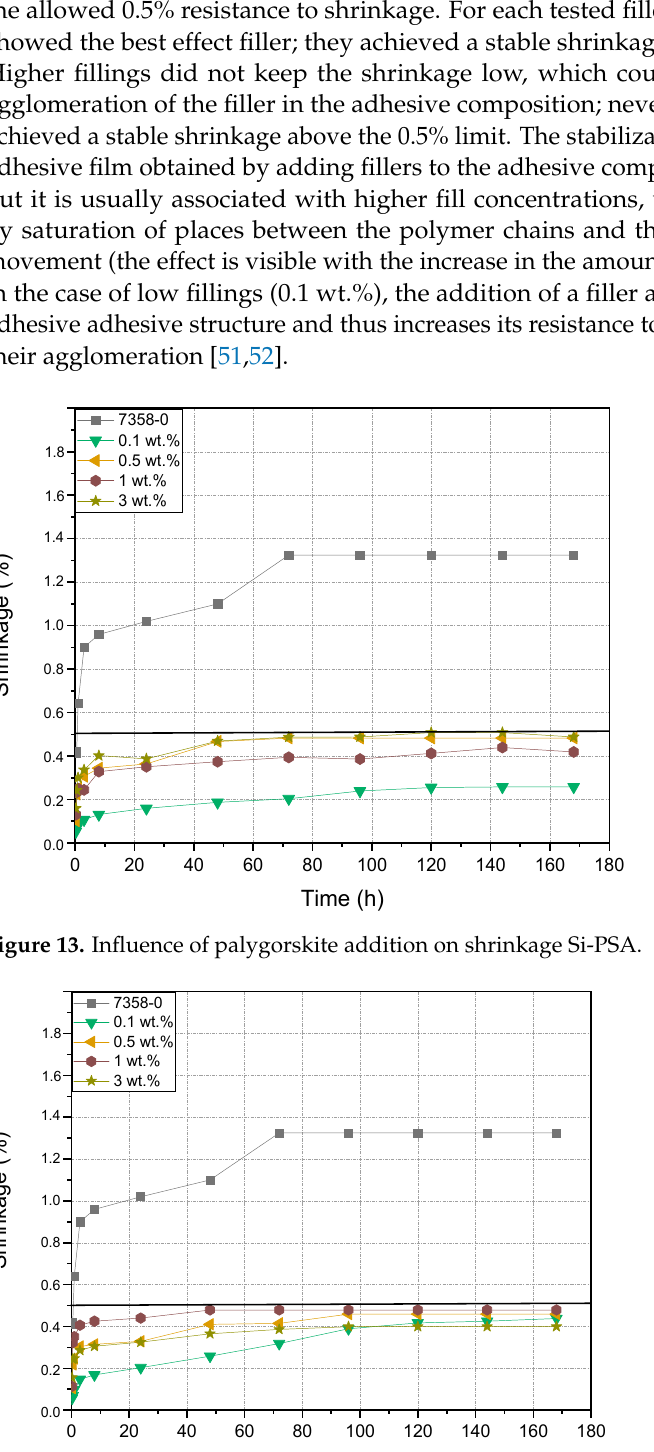
Figure 15. Influence of palygorskite-1.0MPTMS addition on shrinkage Si-PSA. Figure 16. Influence of palygorskite-1.5MPTMS addition on shrinkage Si-PSA.